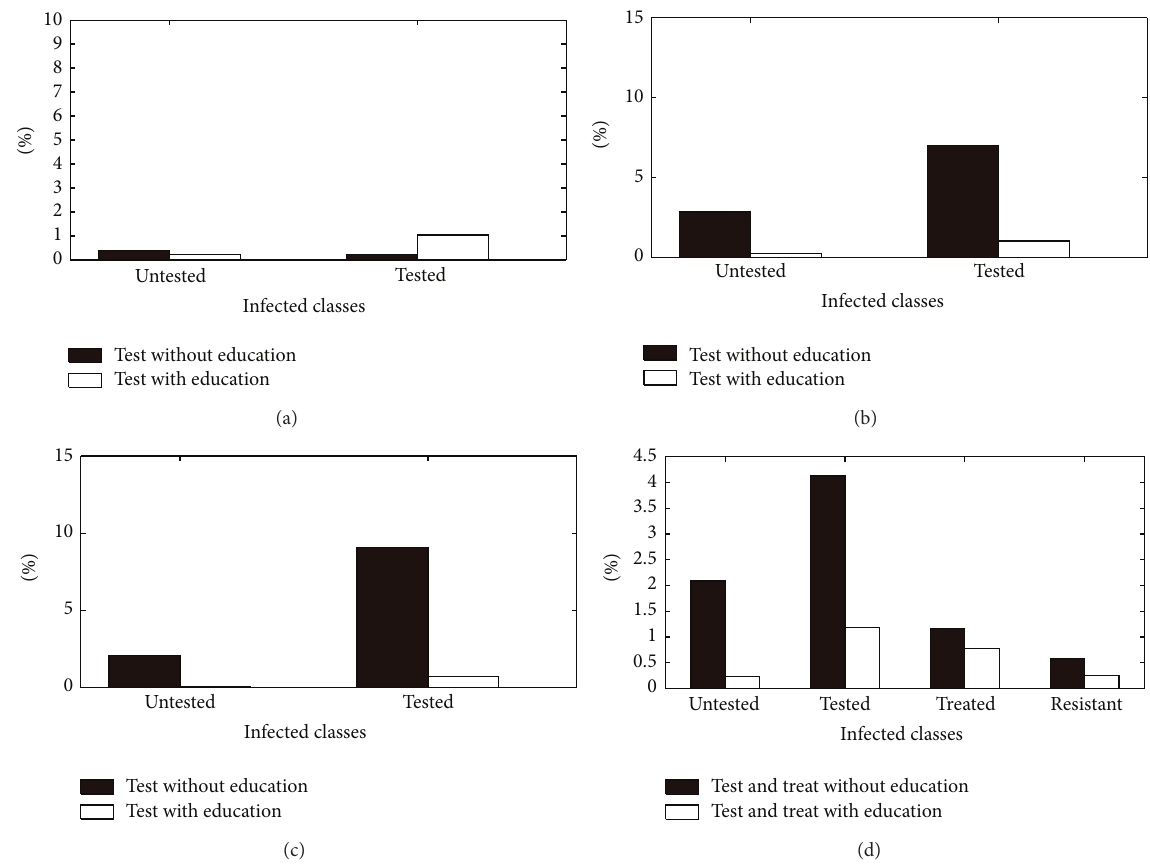
Figure 6: The effects of education on the number of infected individuals (total population started with is 1450) after 10 years. (a) Comparison between percentage of infected in different classes when early education ( 𝑝 = 0 . 75, 𝜌 𝑒 = 0 . 25) and late education ( 𝑝 = 0 . 25, 𝜌 𝑒 = 0 . 75) are considered in the limited-education model (19). (b) Comparison between percentage of infected individuals in different classes when average testing is provided ( 𝜎 𝑘 = 0 . 55), in the absence of education ( 𝑝 = 0, 𝜌 𝑒 = 0) and when partial education is provided ( 𝑝 = 0 . 75, 𝜌 𝑒 = 1) in the limited-education model. (c) Comparison between percentage of infected individuals in different classes when rapid testing is adopted ( 𝜎 𝑘 = 1), in the absence of education ( 𝑝 = 0, 𝜌 𝑒 = 0) and when limited education is provided ( 𝑝 = 0 . 75, 𝜌 𝑒 = 1) in the limited-education model. (d) Comparison between percentage of infected in different classes in the absence of education and when limited education is provided ( 𝑝 = 0 . 75, 𝜌 𝑒 = 1, and 𝜌 𝑒𝑡 = 1) in the full model. Here low treatment is considered ( 𝜎 𝑡 = 𝜎 𝑒𝑡 = 0 .